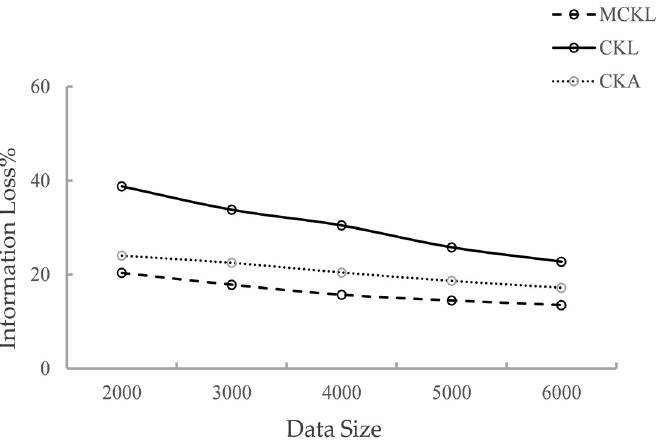
Figure 3. Information loss with larger dataset sizes.